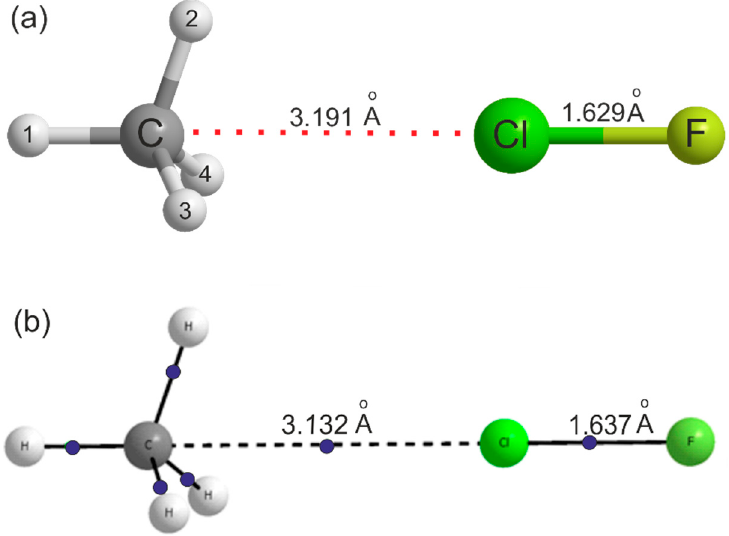
Figure 2. ( a ) The symmetry and geometry of the H 4 C  ClF complex as optimised ab initio at the